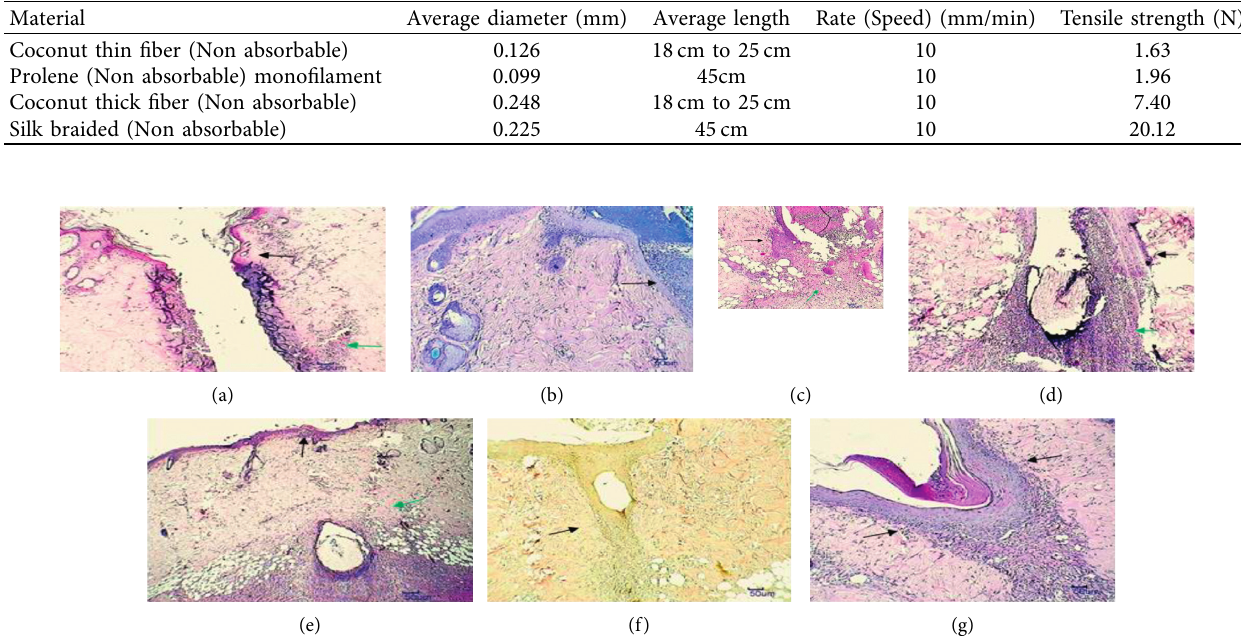
Figure 3: Histopathological indications of immature coconut fiber (multifilament) sutured skin area sections. (a) 24hrs—hematoxylin and eosin (H and E) 10x, necrosis of epidermal and dermal cells, mild neutrophilic infiltration. (b) 48hrs—Giemsa 10x, epithelial cell migration and moderate neutrophilic infiltration. (c) 72hrs—H and E 10x, moderate epidermal proliferation, mild granulation tissue invasion. (d) 96hrs—H and E 10x, epidermal layer thickening, moderate granulation tissue formation. (e) 120hrs—H and E 10x, moderate